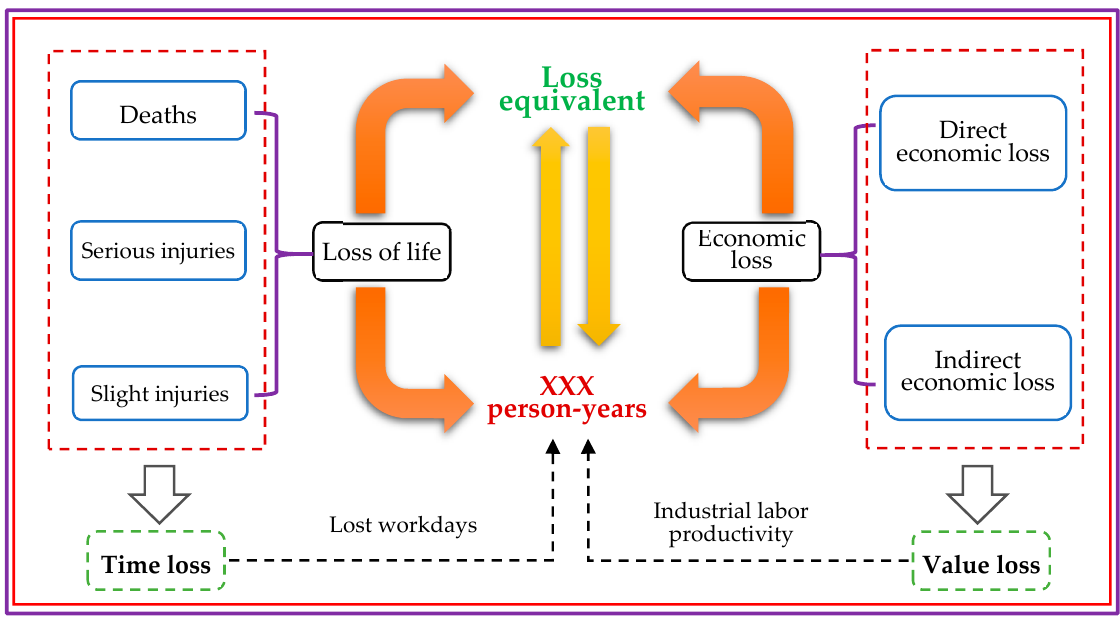
Figure 1. Schematic diagram of the dimensional normalization process of various losses 150